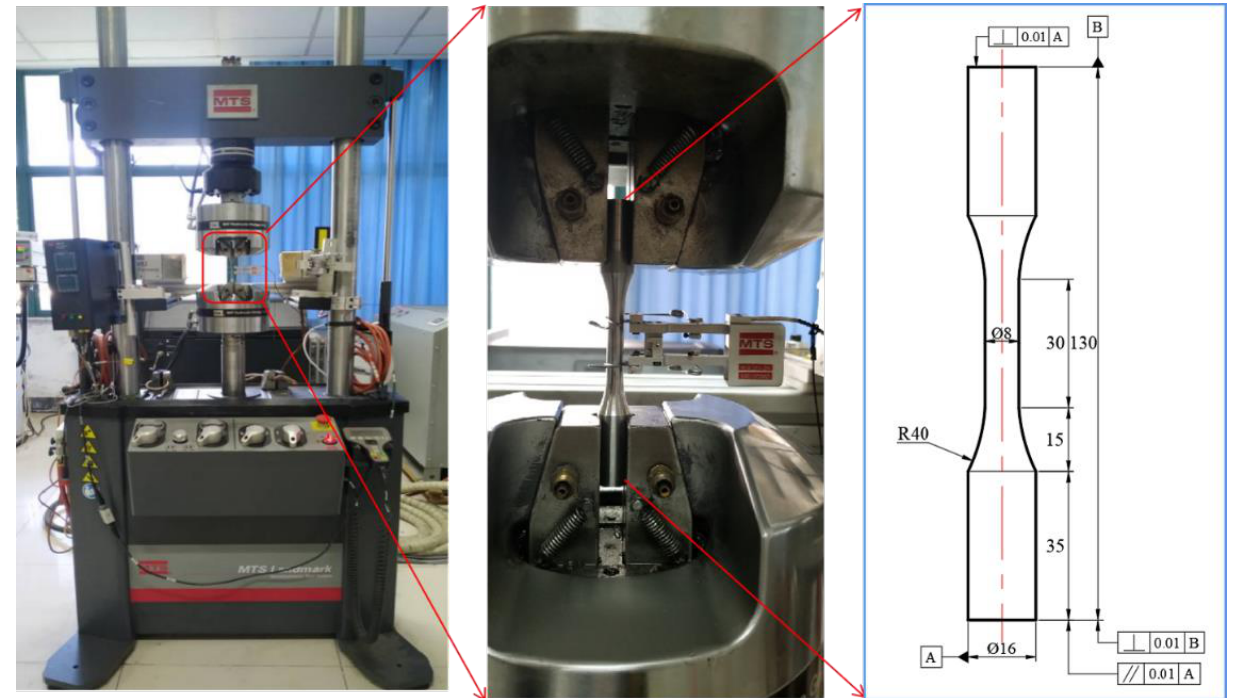
Figure 2. Experimental setup of LCF tests and detailed dimensions of specimens.